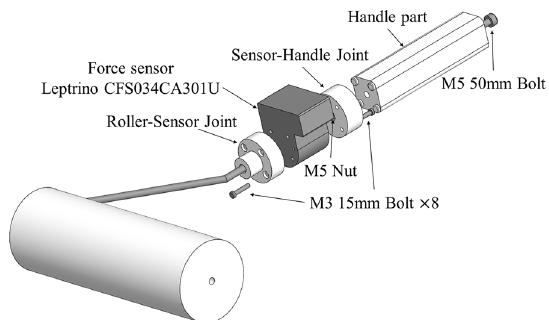
Fig. 6 Structure of the roller brush device